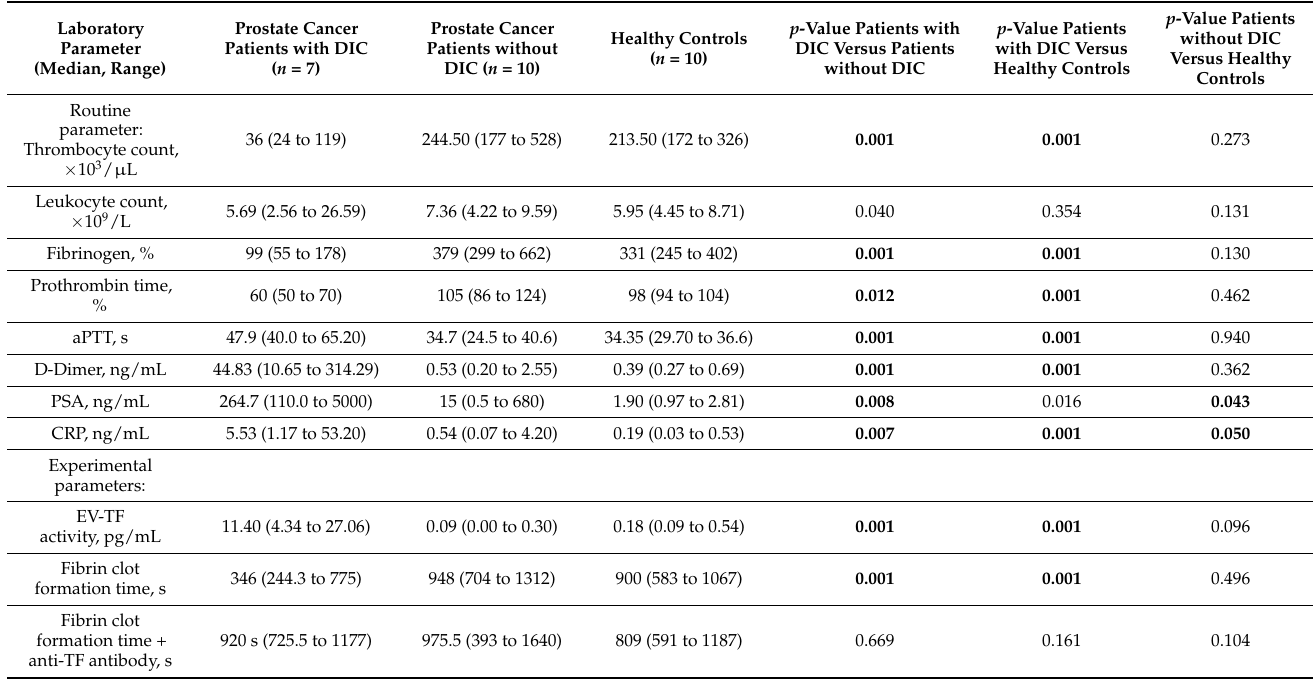
Table 2. Routine and experimental laboratory parameters of prostate cancer patients with DIC, age- and stage-matched prostate cancer patients without DIC, and age-matched healthy